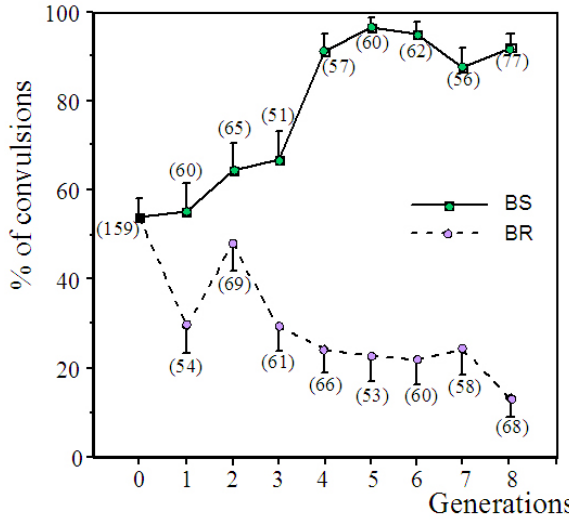
FIGURE 8. Selection of two mouse strains sensitive (BS) or resistant (BR) to a convulsive dose of beta-CCM. Following Mendelian principles (see text), two mouse strains were selected for their response to a single convulsive dose of beta-CCM (4 mg/kg, i.p . ). The percentage of subjects in each generation is given in parentheses. The percentage of convulsing mice increased quickly in sensitive mice (BS) and the opposite was observed in resistant mice (BR). (Adapted from Chapouthier et